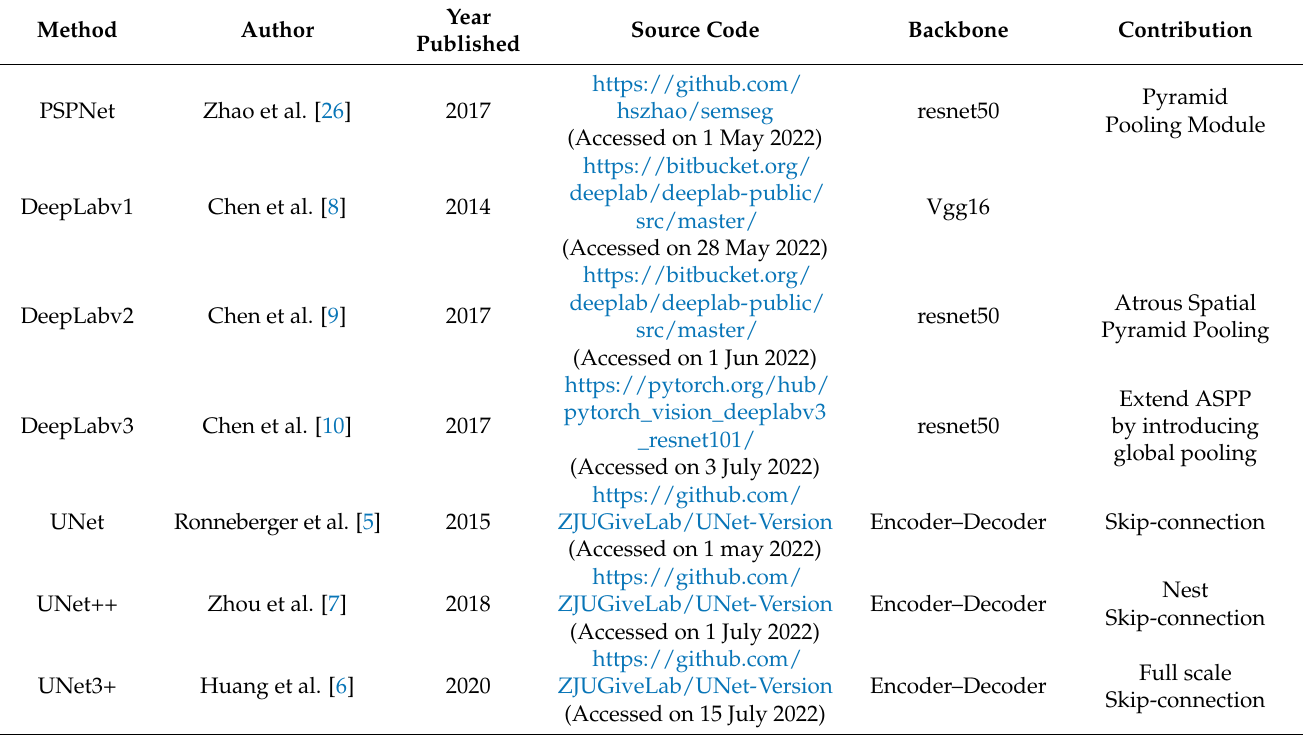
Table 2. Specifications of classical models.